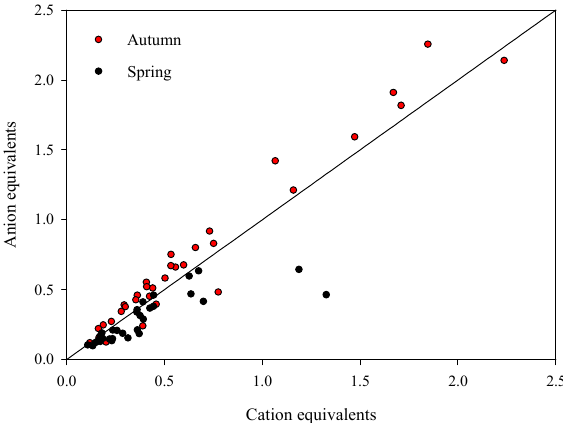
Figure 5. Scatter plots of total anions vs total cations in the fall of 2017 and spring of